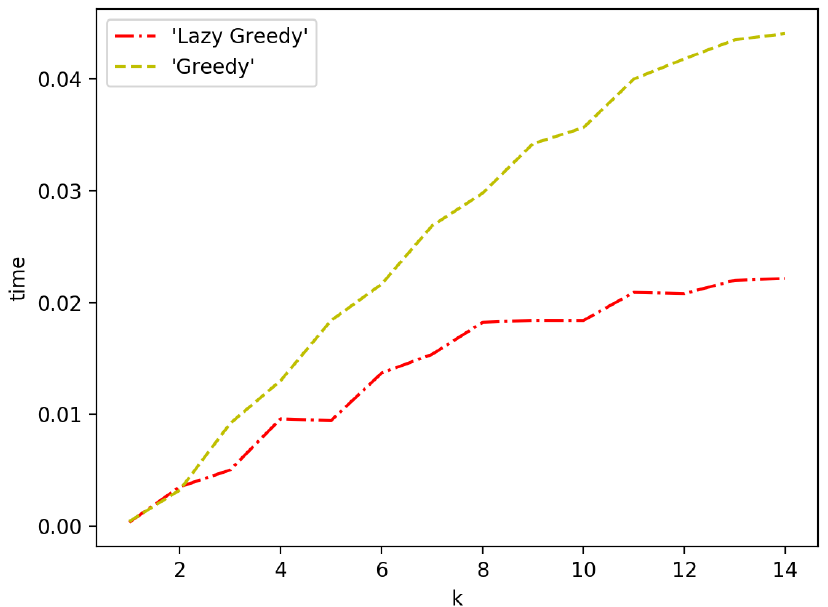
Figure 10. Greedy vs. lazy greedy for one-with-all